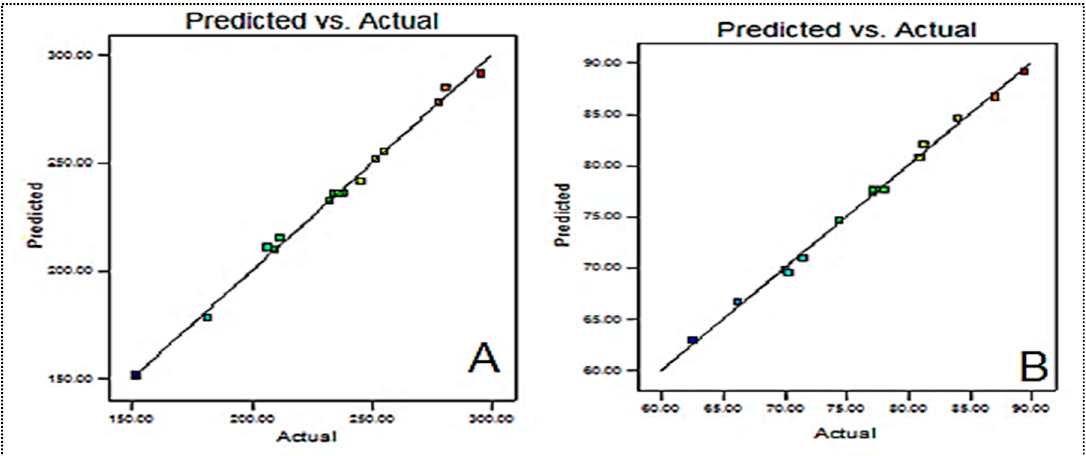
Figure 3. Predicted and actual results of ( A ) particle size and ( B ) entrapment efficiency.